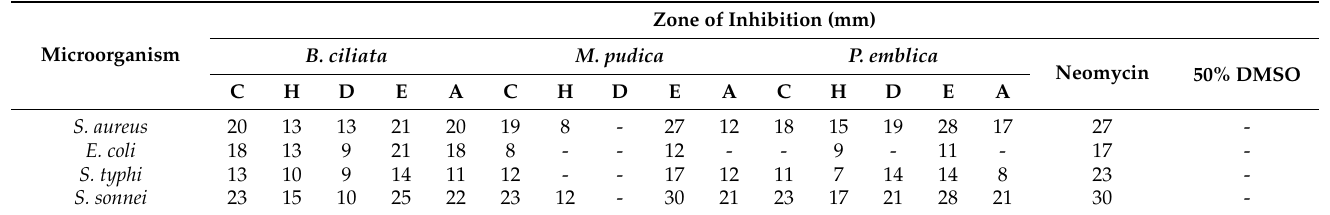
Table 3. Zone of inhibition of different solvent fractions of plant extracts against B. ciliata , M. pudica , and P. emblica .